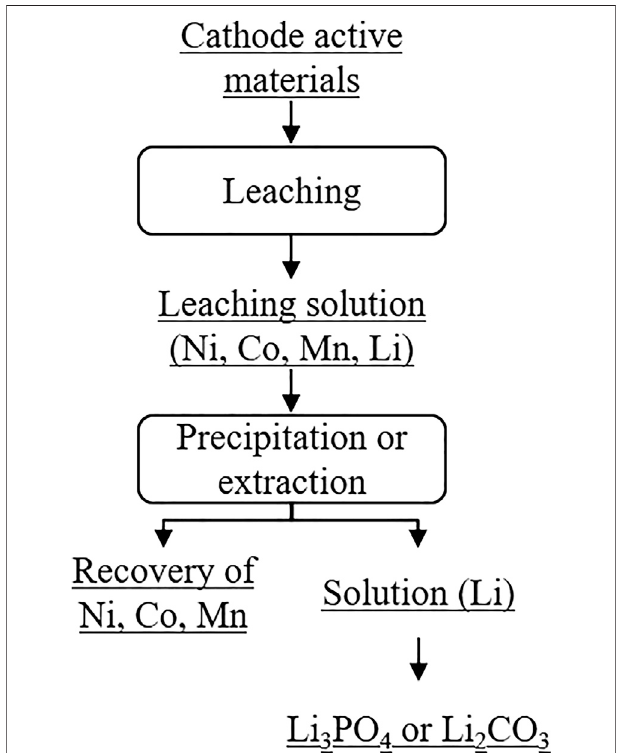
FIGURE 7 | Recovery of active cathode materials from lithium-ion batteries (Liu et al., 2019).